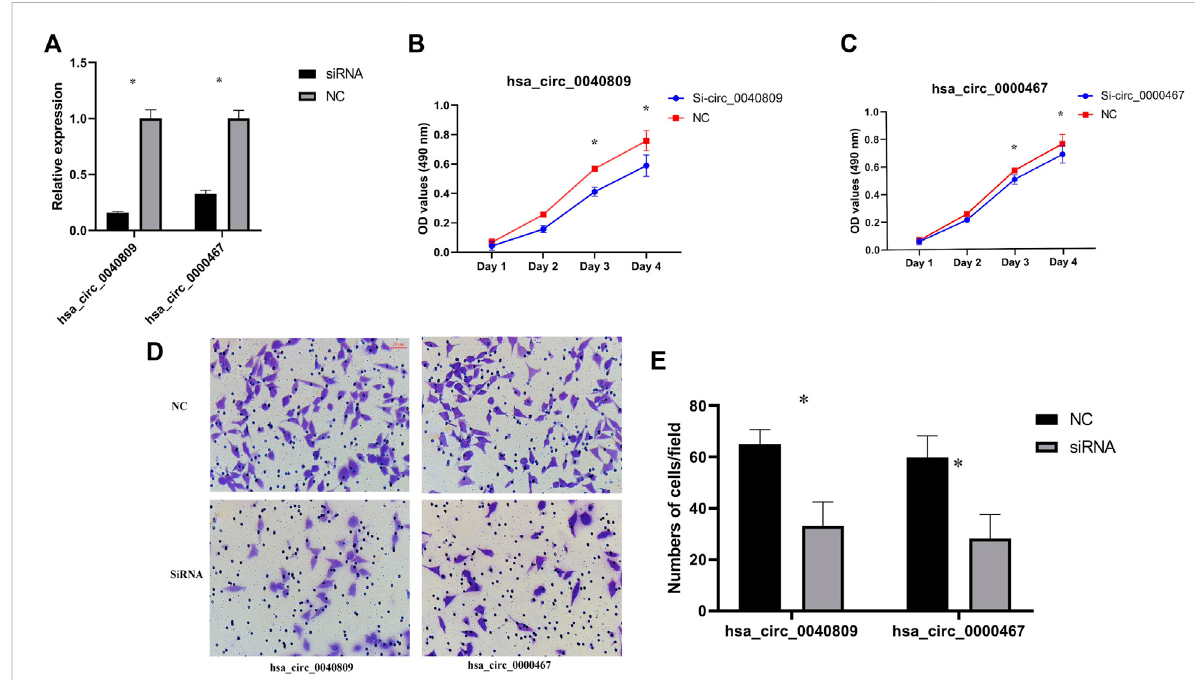
FIGURE 2 Hsa_circ_0040809 and hsa_circ_0000467 promote HCT116 cells proliferation and migration. (A) The ef fi ciency of knockdown hsa_circ_0040809 and hsa_circ_0000467. (B) The effect of siRNA-hsa_circ_0040809 on HCT116 cells proliferation. (C) The effect of siRNA- hsa_circ_0000467ontheHCT116cellsproliferation. (D) ResultsofsiRNA-hsa_circ_0040809andsiRNA-hsa_circ_0000467Transwellmigrationof HCT116 cells. (E) Numbers of migrated cells/ fi